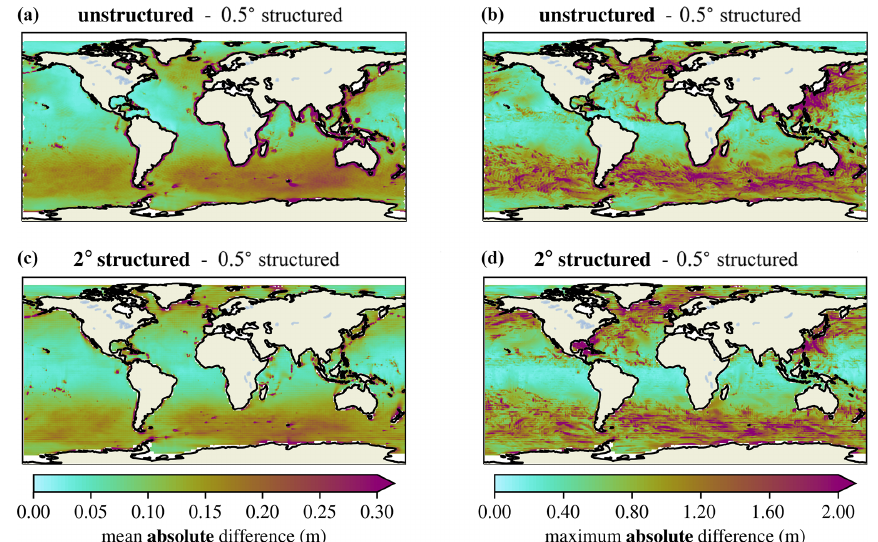
Figure 11. Mean (a, c) and maximum (b, d) absolute differences in significant wave height between the unstructured and 0.5 ◦ structured meshes (a, b) and the 2 and 0.5 ◦ structured meshes (c, d)